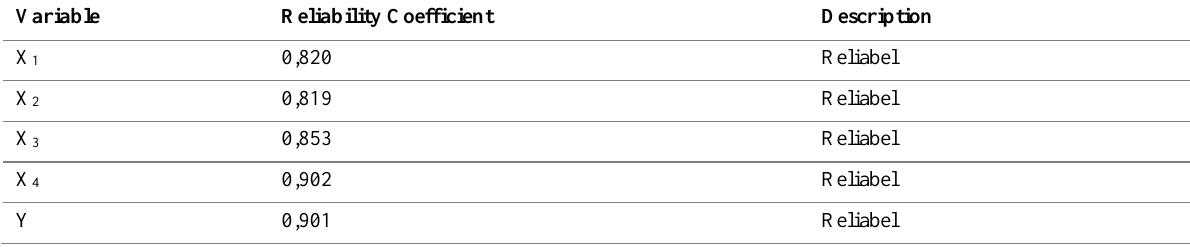
Table 3: Reliability Test